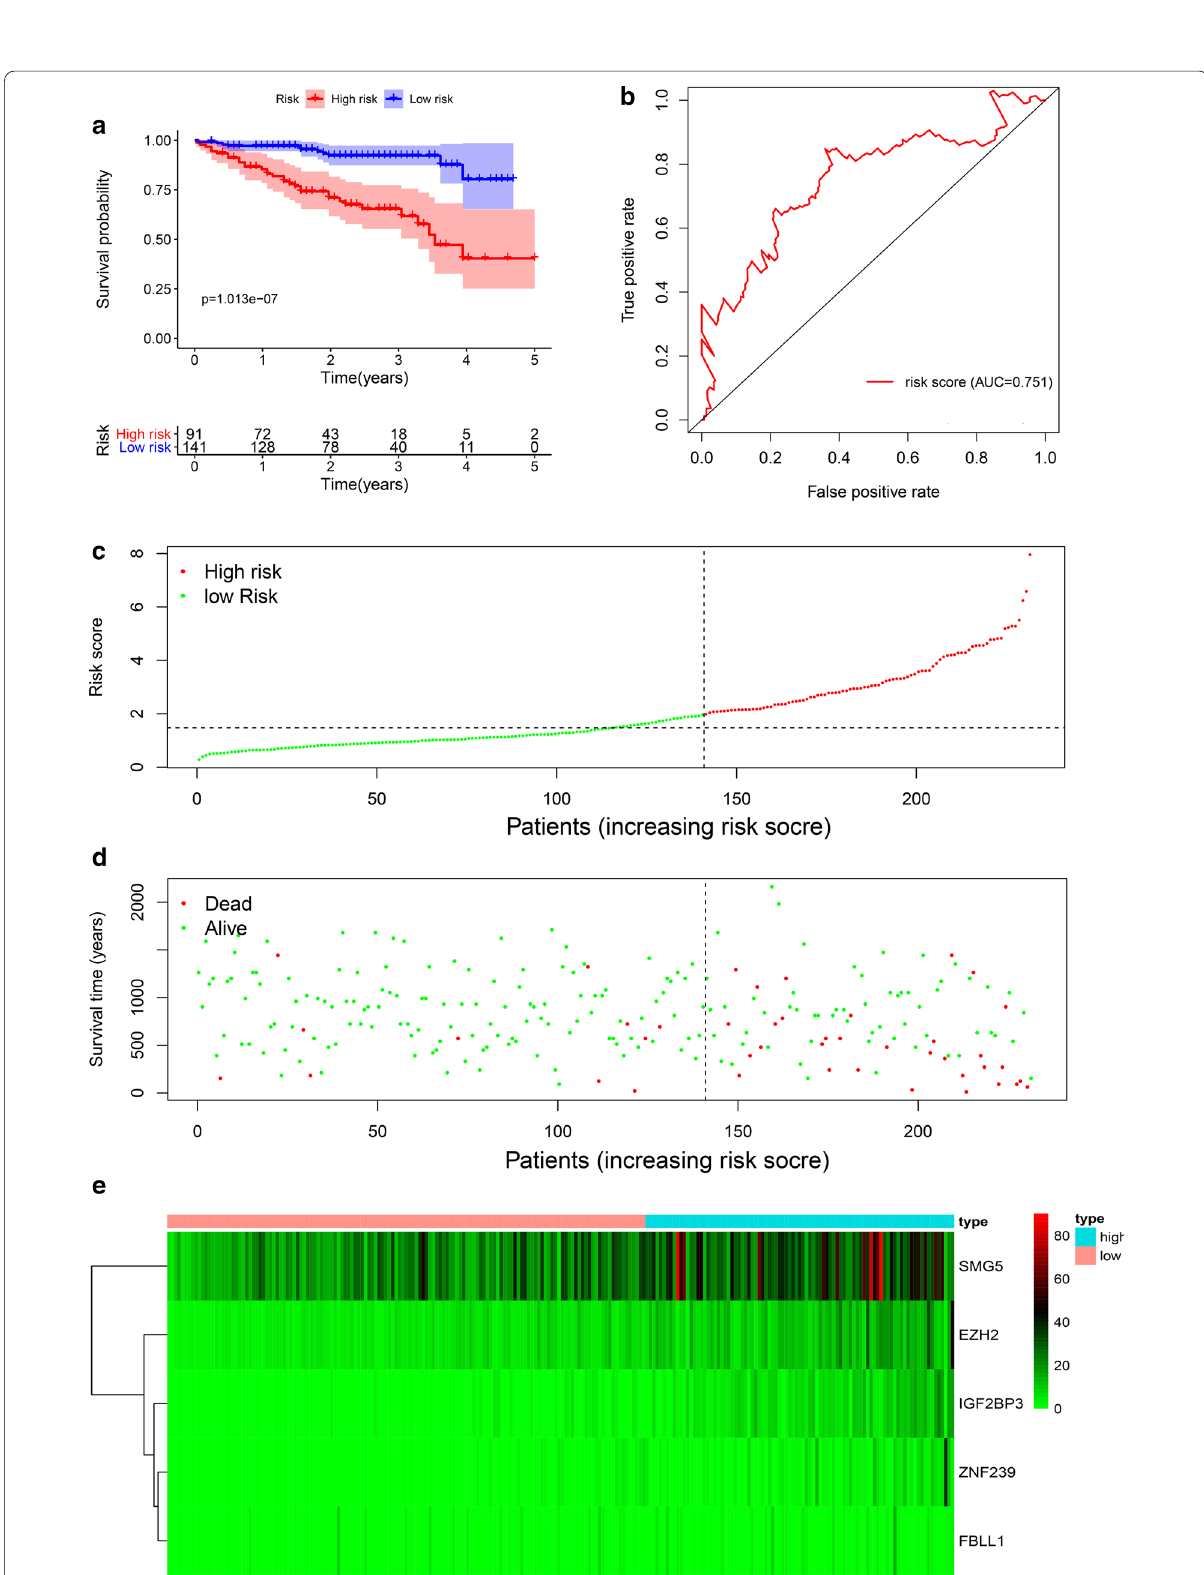
Fig. 8 Gene signature of hepatocellular carcinoma patients in ICGC cohort. a Kaplan–Meier curve of high-risk and low-risk HCC patients. b ROC curve of OS-related gene signature. c Risk score distribution of HCC patients with different risks. d Scatterplots of HCC patients with different survival status. e Heatmap of expression of 5 RBPs in HCC